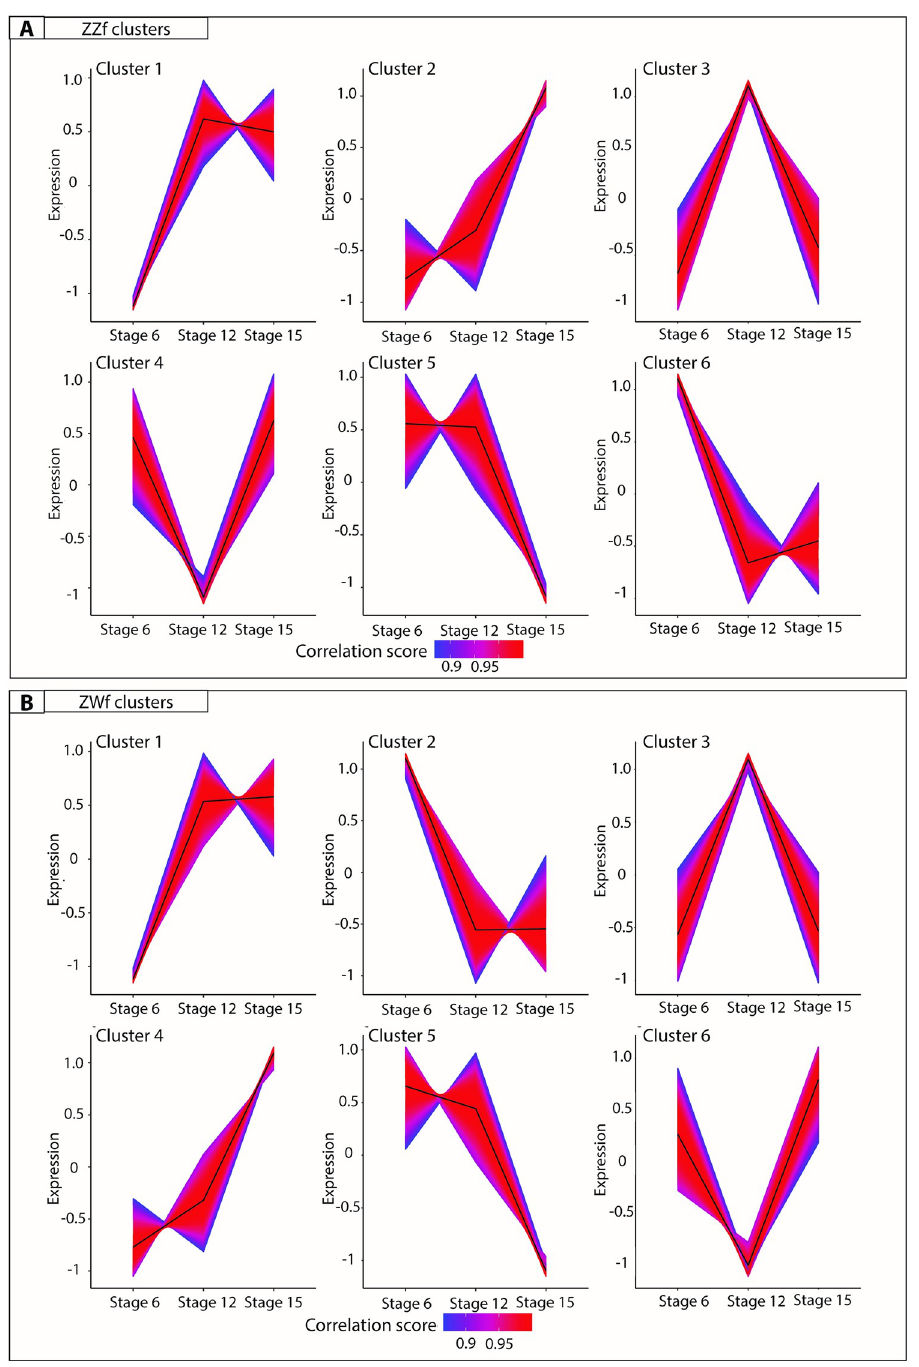
Fig 6. K-means clustering analysis on normalized counts per million for ZZf ( A ) and ZWf ( B ) across all developmental stages. The colour depicts the correlation score of each gene in the cluster, where numbers approaching one (red) have the strongest correlation. All gene lists produced for each cluster are provided in S5